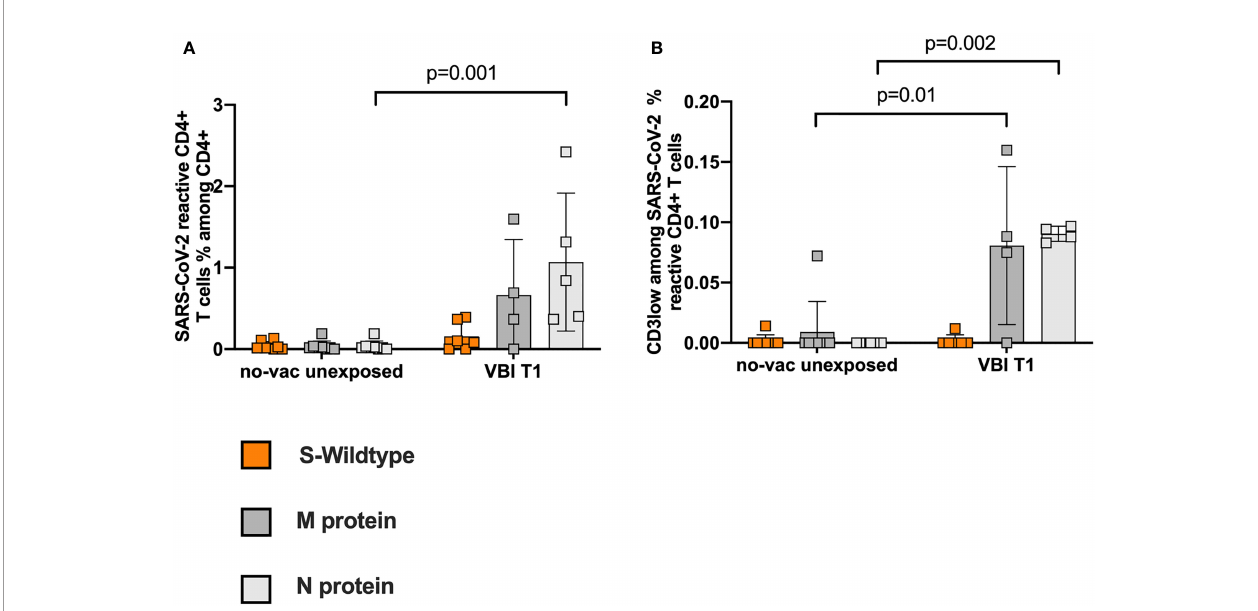
FIGURE 5 | Low frequencies of pre-existing SARS-CoV-2 reactive T cells with low avidity in the unvaccinated unexposed controls. PBMCs from 8 individuals, unexposed to SARS-CoV-2, were analyzed for pre-existing SARS-CoV-2 reactive CD4+ T cell response. (A) Low frequencies of pre-existing cross-reactive CD4 reactive T cells compared to VBI patients at T1. (B) The avidity of M- and N-CD3low populations is signi fi cantly lower among the no-vac unexposed